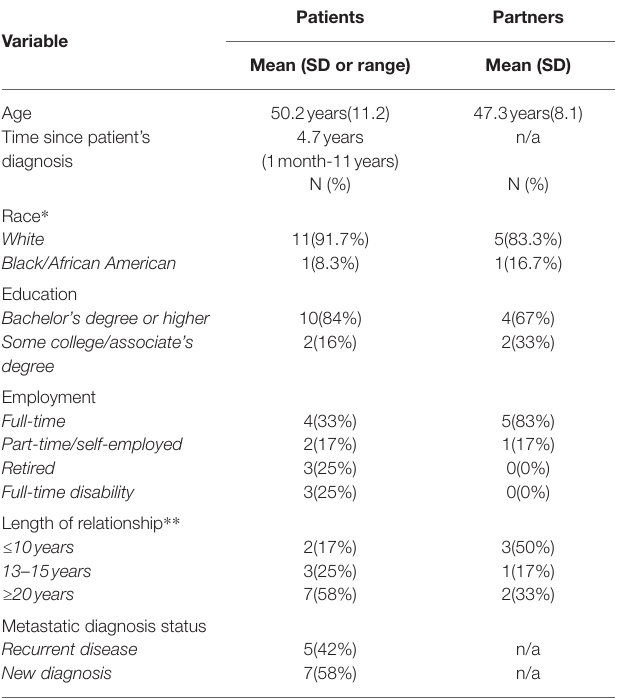
TABLE 2 | Patient and partner